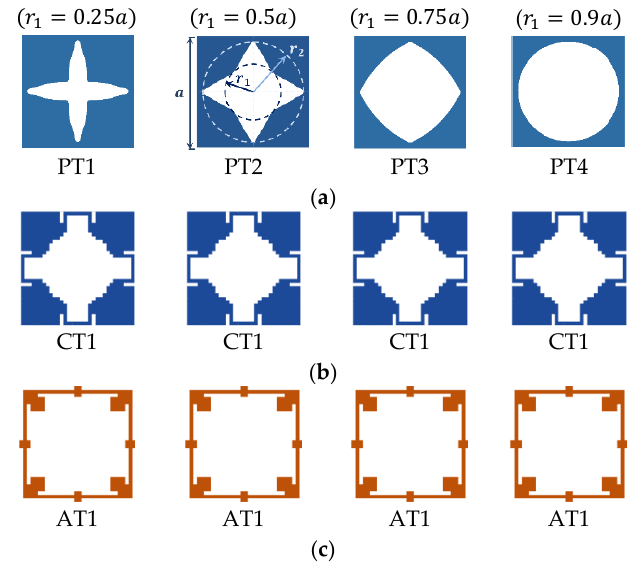
Figure 2. Perforation profiles chosen to study the bandgap efficiency of OPhPs, ( a ) prescribed topologies with arbitrary perforation profile ( 𝑟 2 = 0.9𝑎 and different 𝑟 1 ), and optimized topologies with ( b ) maximized complete bandgap of mixed guided waves and ( c ) maximized bandgap of asymmetric guided wave modes [10].